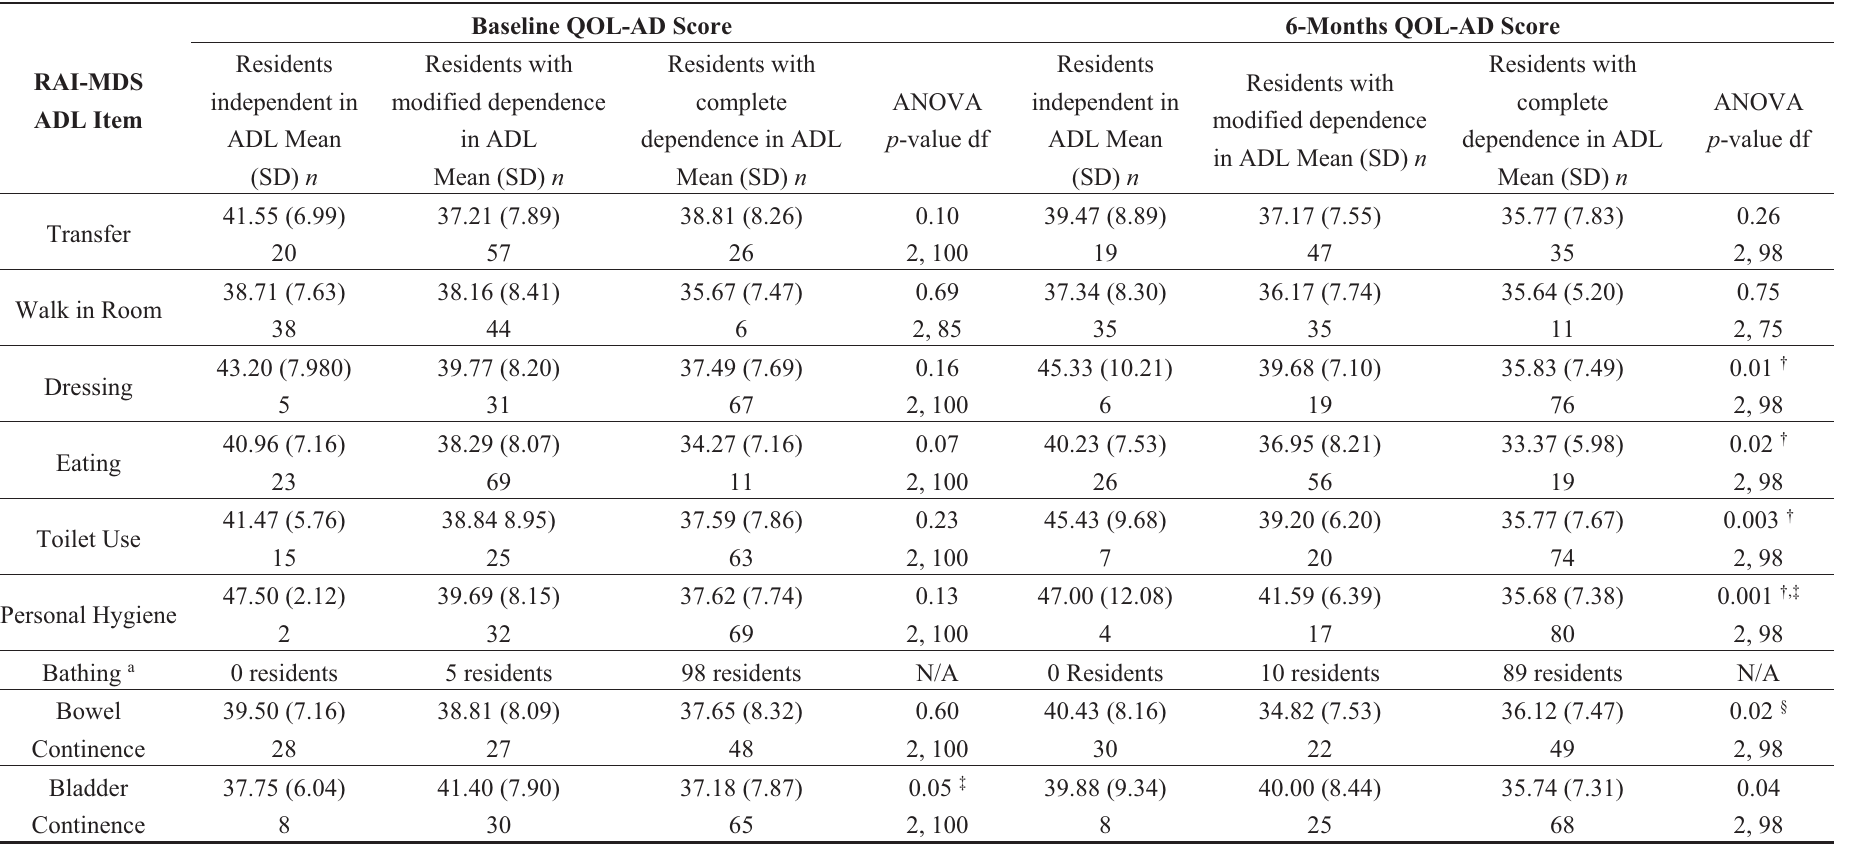
Table 2. QOL-AD mean scores across three levels of dependency for each RAI-MDS ADL